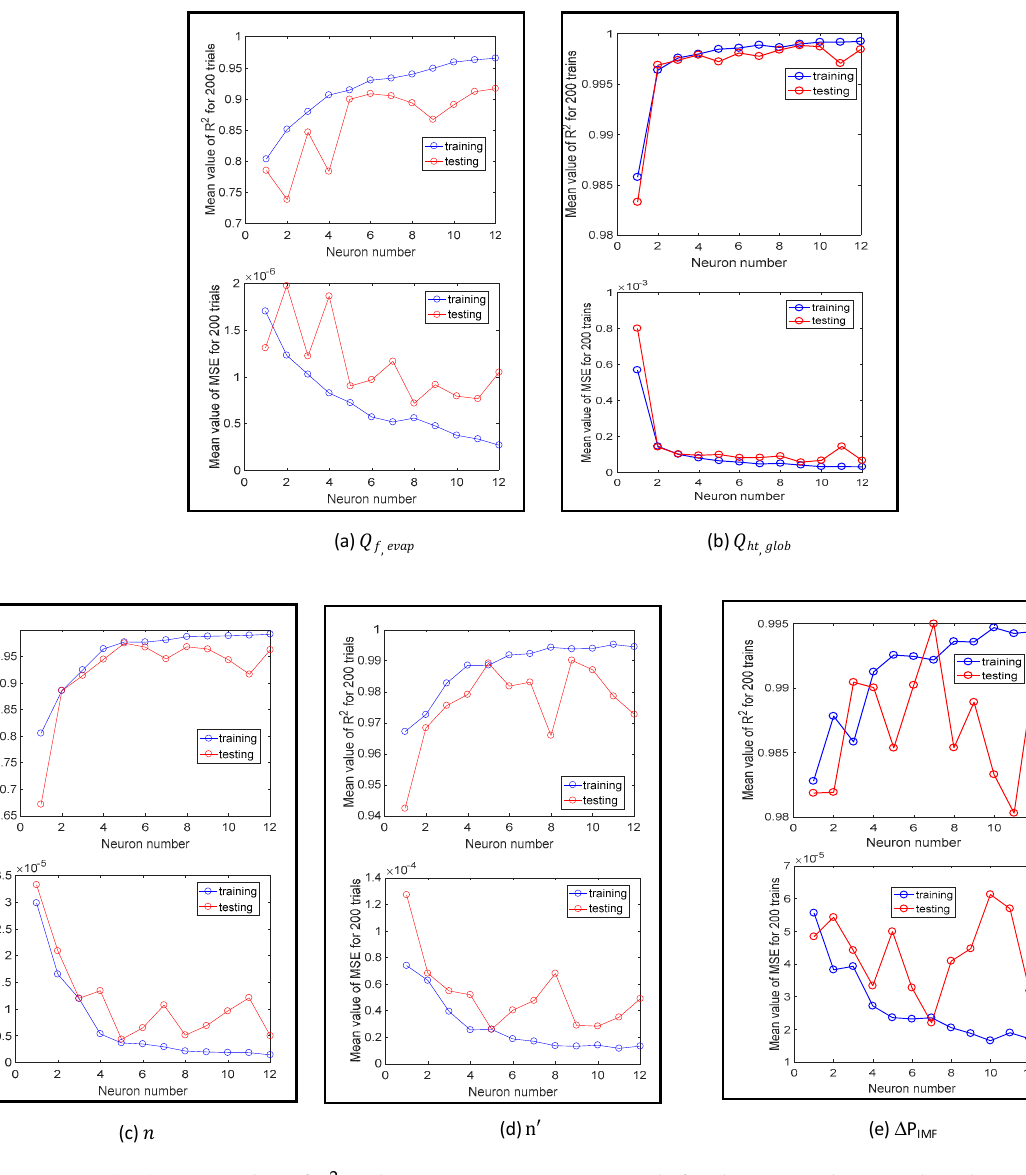
Figure A4. ( a – e ) Mean value of R 2 and MSE over 200 training trials for the ANNs that simulate the different parameters of the physics-based model (pressure simulation), as a function of the number of neurons.